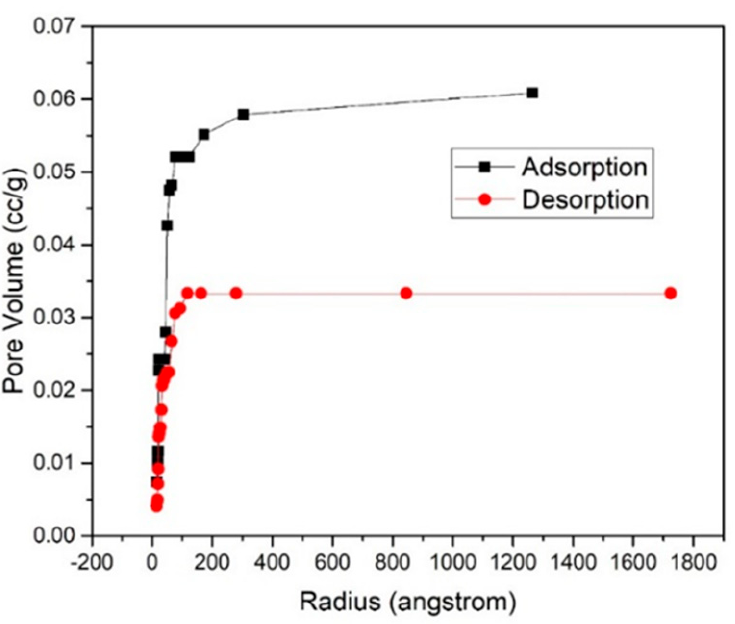
Figure 6. Adsorption-Desorption Curve 7% PVP.